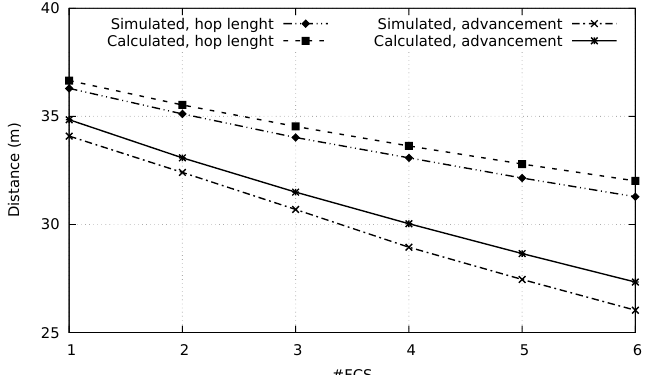
Figure 6. Average advancement and average hop length for distinct FCS cardinalities. η = 6 × 10 − 3 node m 2